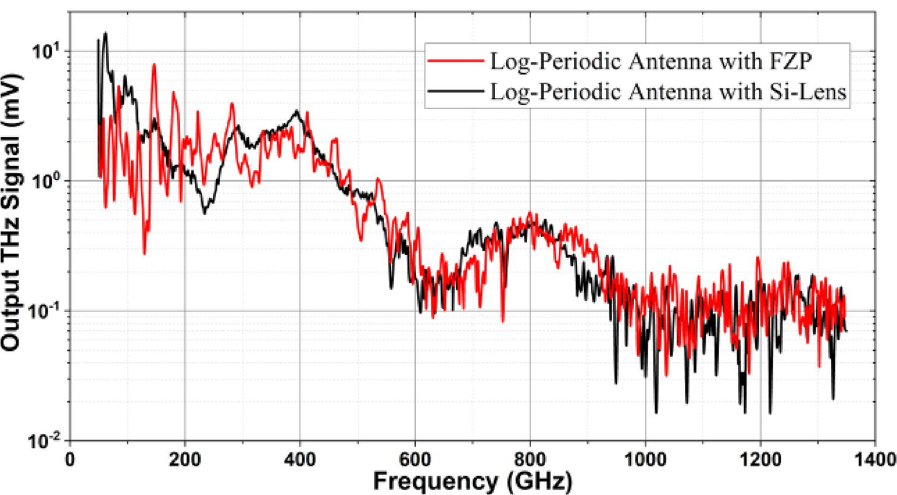
Figure 7. Comparison of the performance of the photomixer with an etching depth of 37 μm and the same photomixer with the